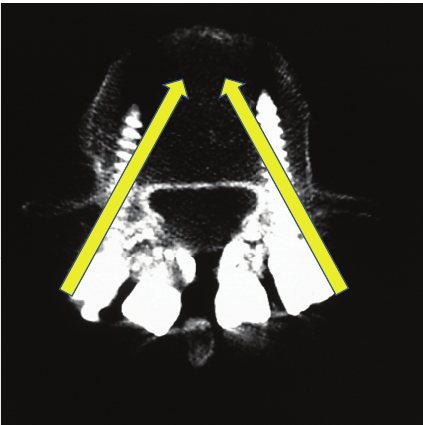
Figure 8: Optimum screw insertion point and direction for mul- tilevel direct repair surgery for the pedicle screw and hook-rod system. The technique may avoid contact between the hook and screw